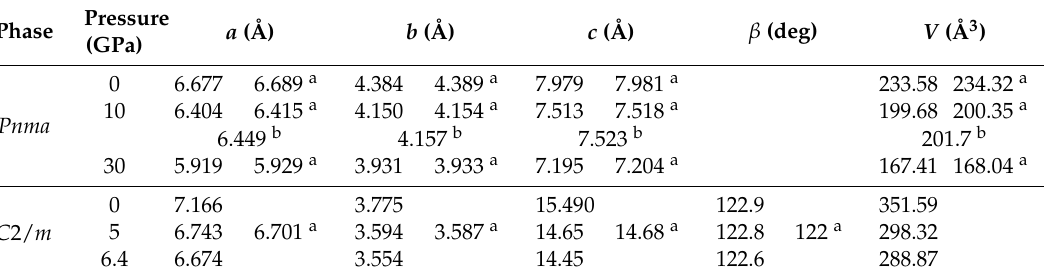
Table 2. Lattice parameters of Ca 2 C at various pressures.